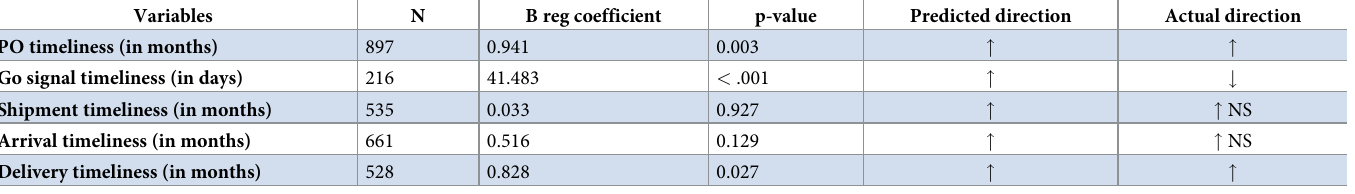
Table 2. Regression results showing the relationship between NTD supply chain key performance indicators and implementation of information sharing through NTDeliver. Variables N Β reg